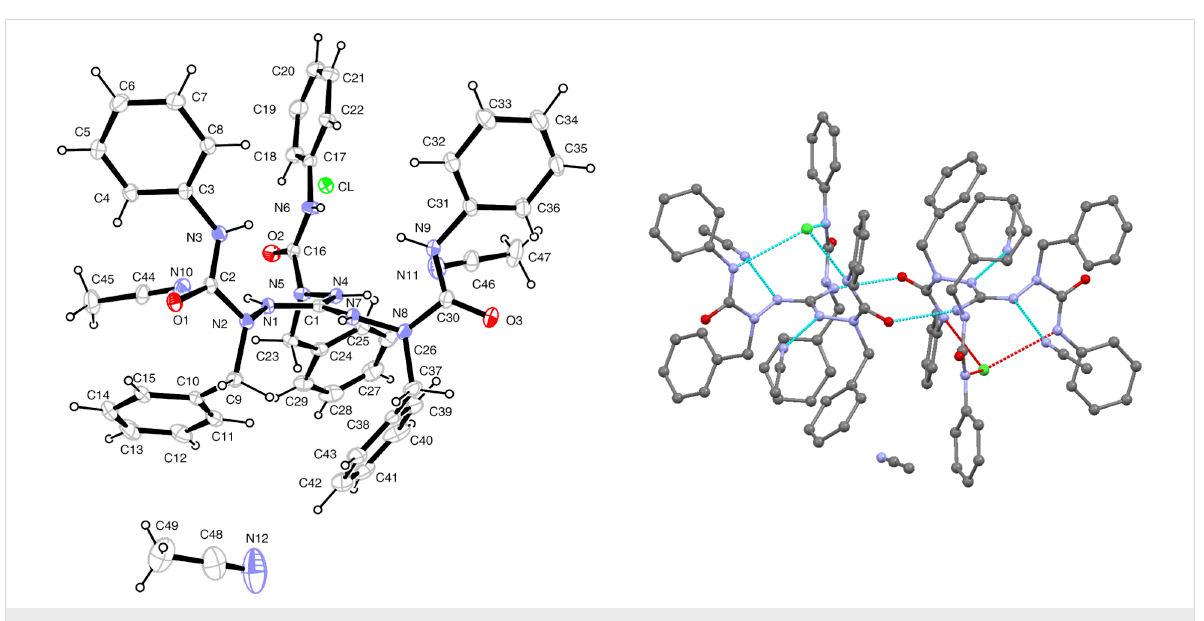
Figure 1: Solid-state structure of 7a ·3CH 3 CN. Left: Molecular structure with numbering of atoms. Right: N–H···Cl, N–H···N(acetonitrile) and N–H···O hydrogen bonds. Thermal displacement ellipsoids are drawn at the 30% probability level. Selected bond lengths (Å): C1–N1 1.330(3), C1–N4 1.333(3), C1–N7 1.332(3), N1–N2 1.397(3), N4–N5 1.388(3), N7–N8 1.401(3). Selected bond angles (°): N1–C1–N4 119.0(2), N1–C1–N7 120.7(2), N4–C1–N7 120.3(2). For torsion angles and hydrogen bonds, see Table 1 and Table S4 (Supporting Information File